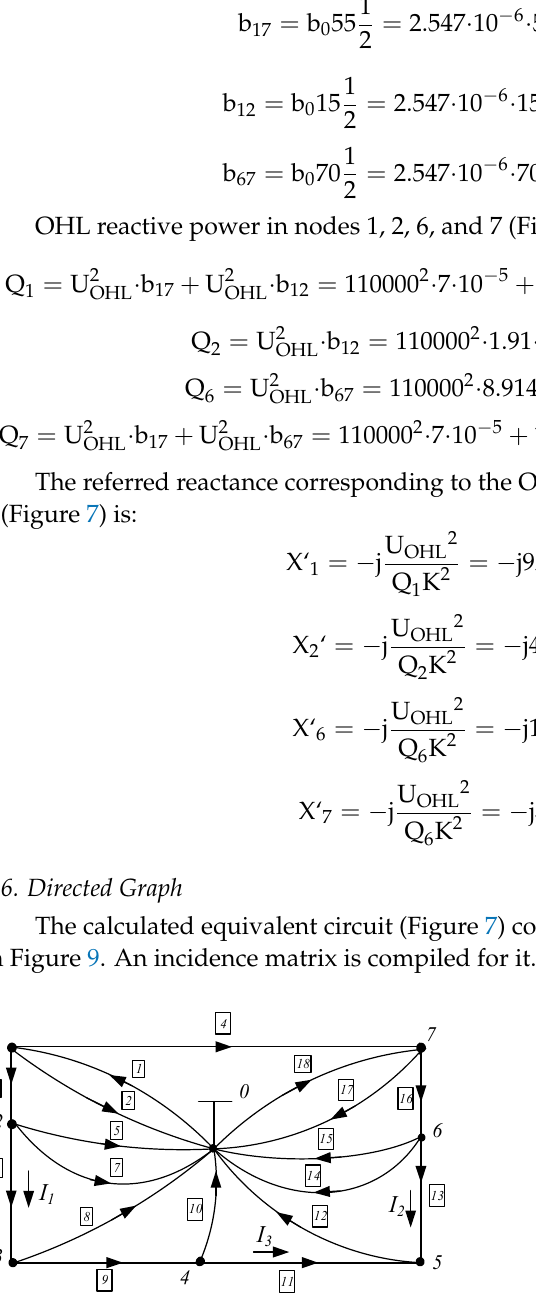
Figure 9. Directed graph of the DN.